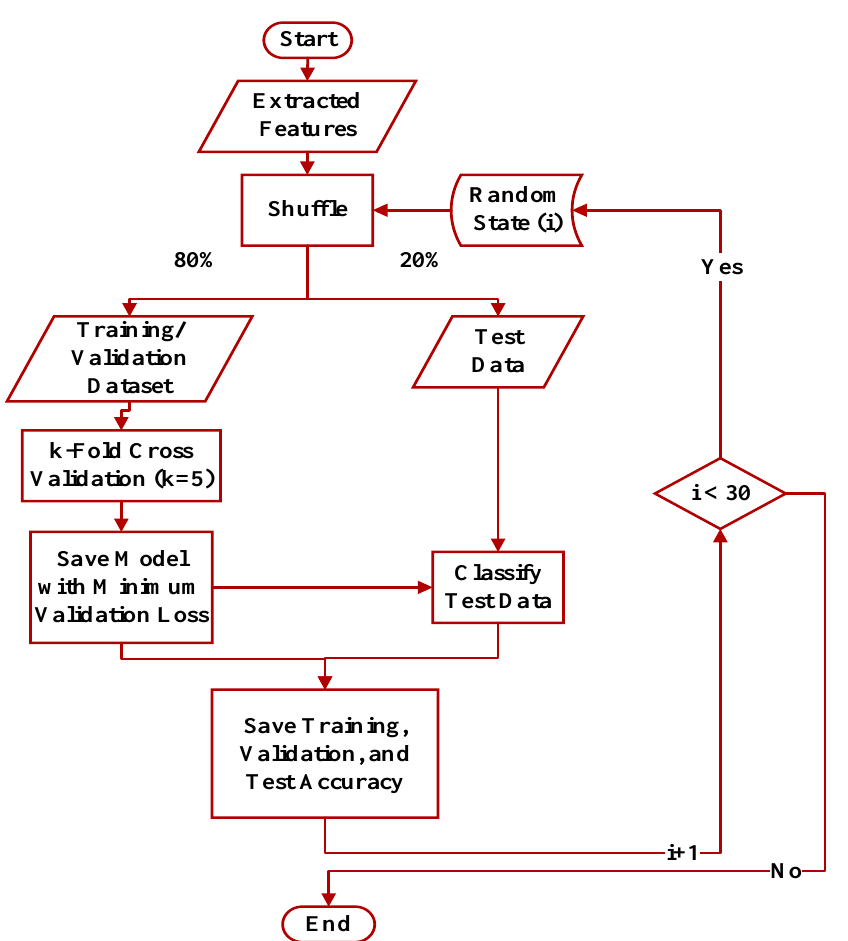
Figure 6. The process of training models and saving training, validation, and test accuracies.